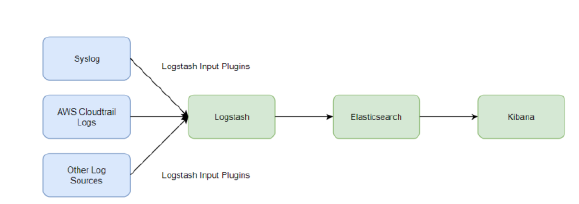
Figure 2. Elastic Stack Sample